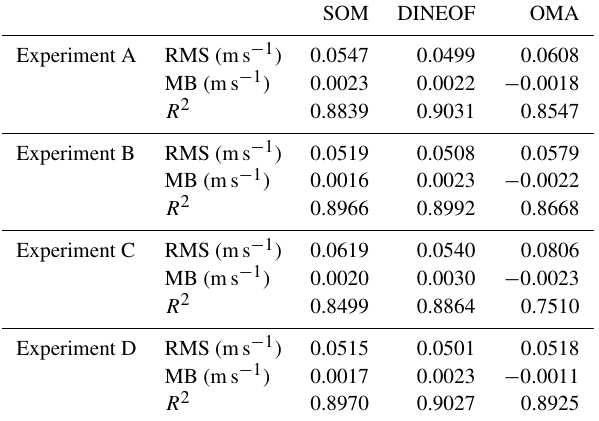
Table 2. Root mean square (RMS) error, mean bias (MB) and cor- relation coefficient ( R 2 ) of the meridional velocities ( v ) obtained using reconstructed HFR datasets from the three methodologies and for the four experiments with respect to the zonal velocities derived from the reference HFR